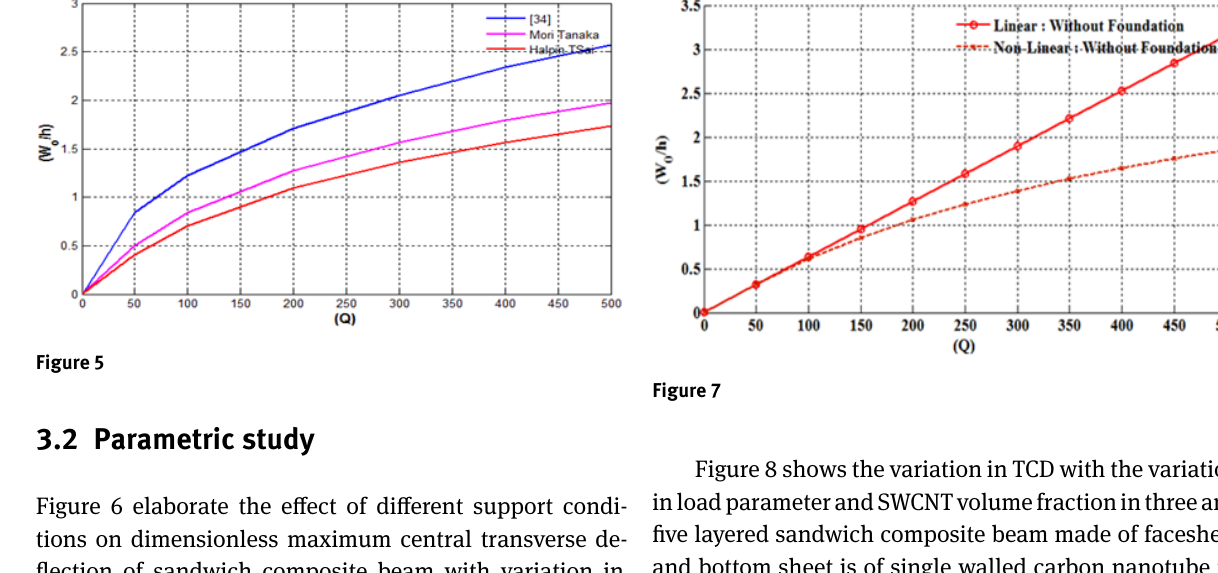
Figure 6 elaborate the effect of different support condi- tions on dimensionless maximum central transverse de- flection of sandwich composite beam with variation in load parameter. The sandwich beam considered of three layered, made of laminated composite facesheet and bot- tom sheet, [90/C/90], a/h=10. It is concluded that, among the clamp-clamp supported (CC), clamped-free supported (CF), clamped-simply supported (CS), hinged-simply sup- ported (HS) and simply supported (SS) boundary condi- tion, minimum transverse central deflection for laminated sandwich composite beam is observed at CC supported condition due to more number of constraints in provided boundary condition. As compared to CF, about 50% less deflection is observed in case of CC support condition.